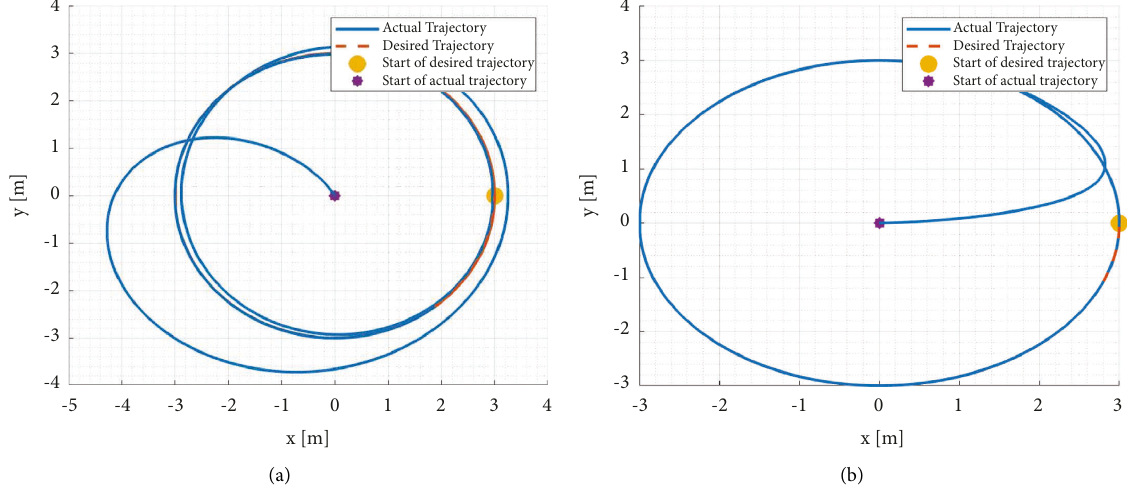
Figure 22: The trajectory for PD (a) and FBL with PD control (b) after 45